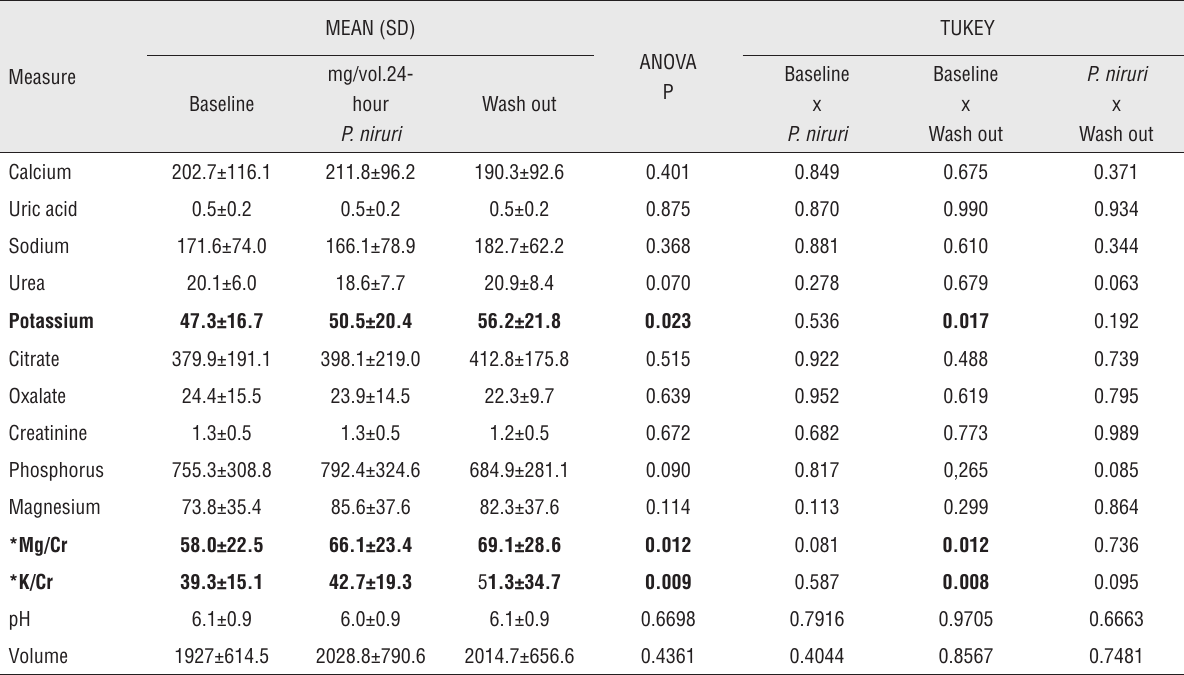
Table 1 - Urinary parameters in patients treated with P.